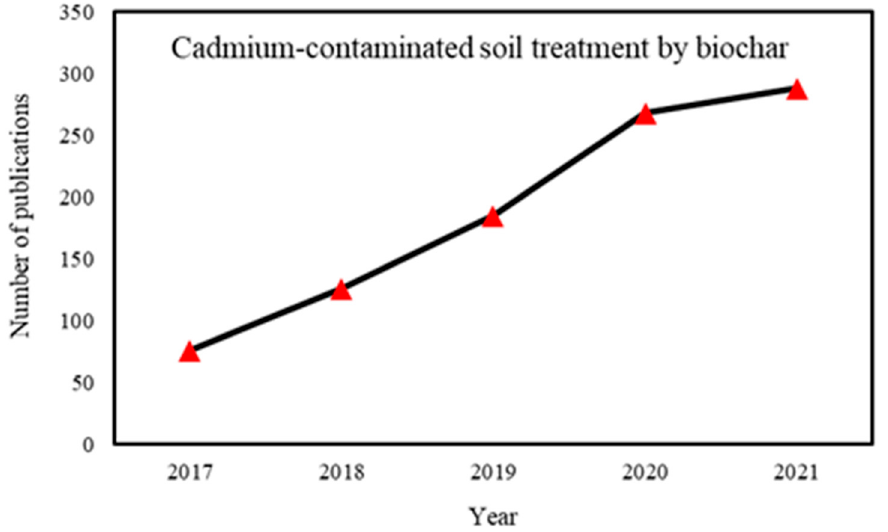
Figure 1. Publications on cadmium-contaminated soil treatment by biochar according to Web of Science (June 2022: “soil,” “biochar,” and “cadmium”).